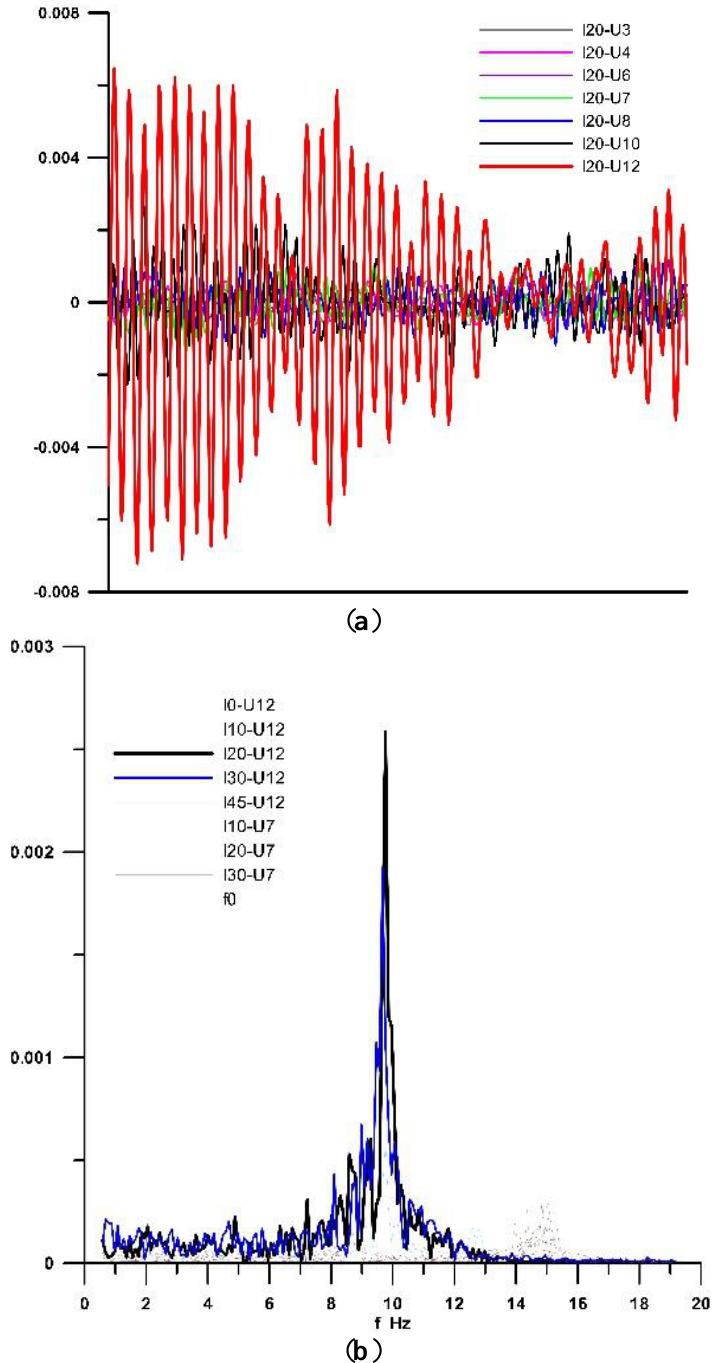
Figure 13. Arch force time series and corresponding spectral plot for each pair of -U test condition ( a , b ).